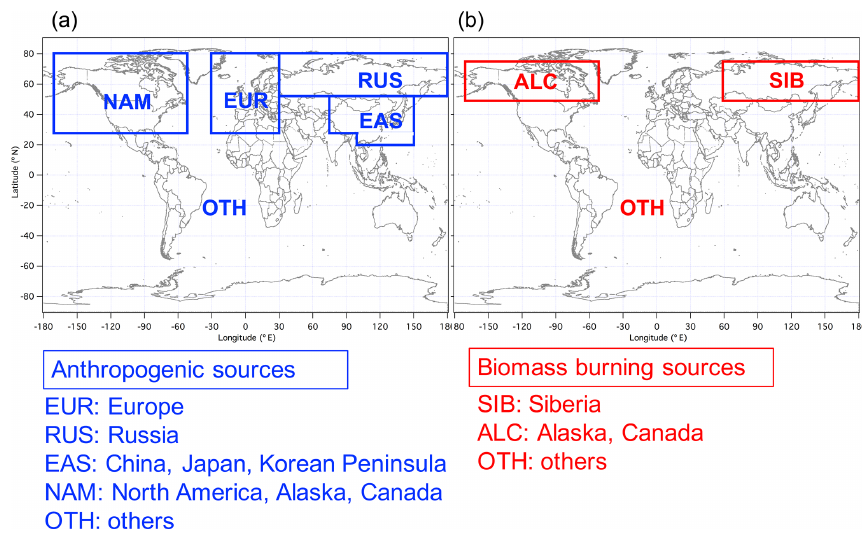
Figure 1. Regional separation for quantification of BC in the Arctic from (a) anthropogenic and (b) open biomass burning sources.